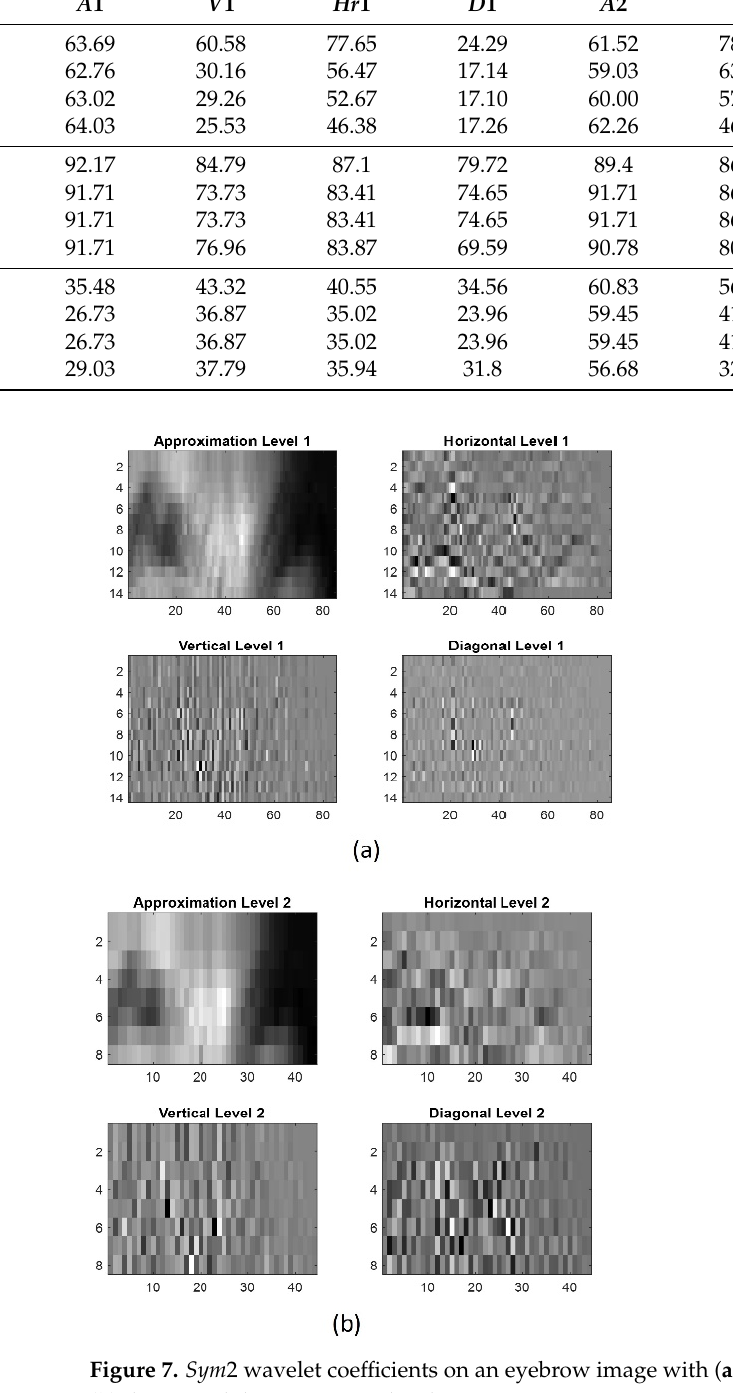
Figure 7. Sym 2 wavelet coefficients on an eyebrow image with ( a ) the first decomposition level and ( b ) the second decomposition